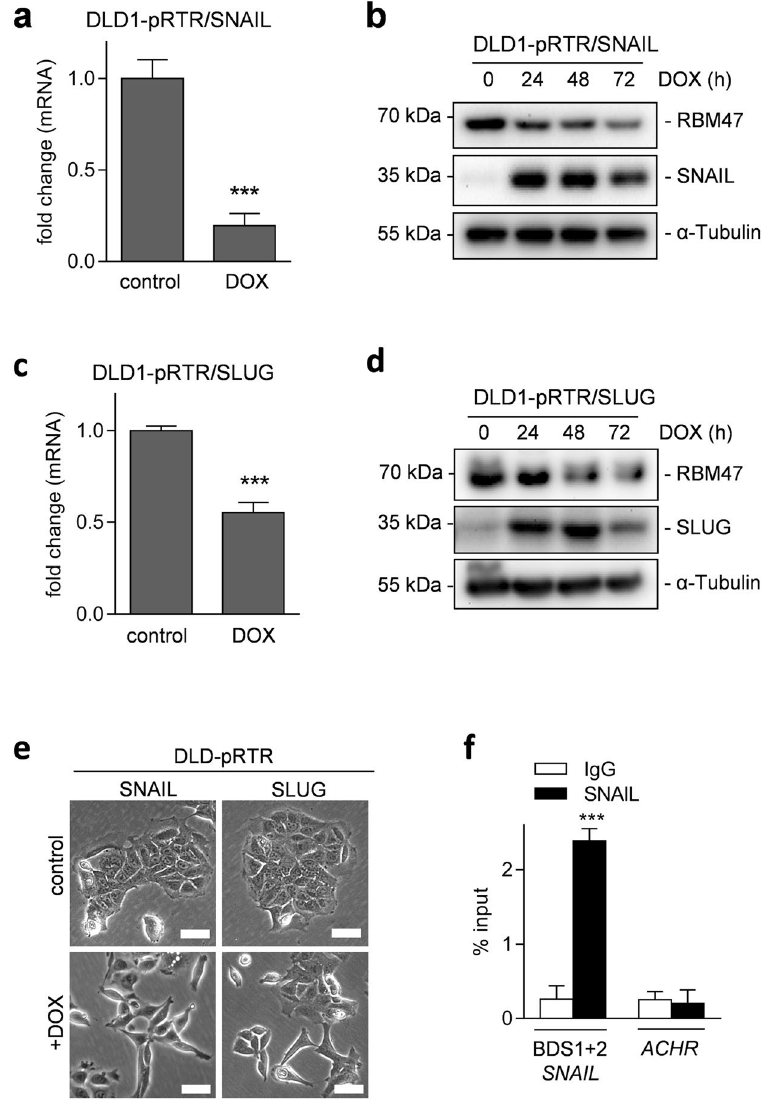
Figure 6. Direct suppression of RBM47 by the EMT-TFs SNAIL and SLUG. ( a ) qPCR analysis of RBM47 mRNA and ( b ) Western blot analysis of the indicated proteins in DLD1 cell pools harboring pRTR/SNAIL plasmids. In ( a ) cells were treated with DOX or vehicle for 72 hours, in ( b ) with DOX for the indicated periods. ( c and d ) as in ( a ) and ( b ) but using DLD1 cell pools harboring pRTR/SLUG plasmids. ( e ) Phase contrast microscopy of the DLD-pRTR/SNAIL and DLD-pRTR/SLUG cell lines treated with vehicle or DOX for 48 hours. Scale bars represent 50 μ m. ( f ) qChIP analysis of SNAIL occupancy at the RBM47 promoter and, as a control, the acetylcholine receptor ( ACHR ) locus in SW480 cells. In a, c, and f mean values ± SD (n = 3) are provided. * P < 0.05; ** P < 0.01; *** P <